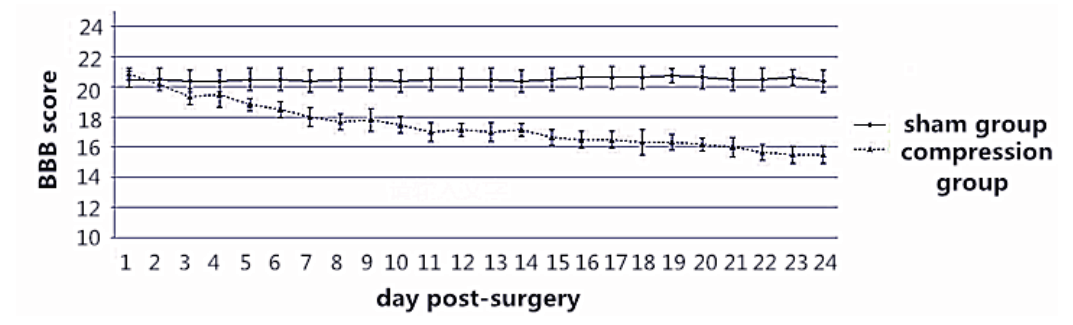
Figure 1. Basso Beattie Bresnahan (BBB) score continued to decline in the compression group, while there was no significant change in the sham group.